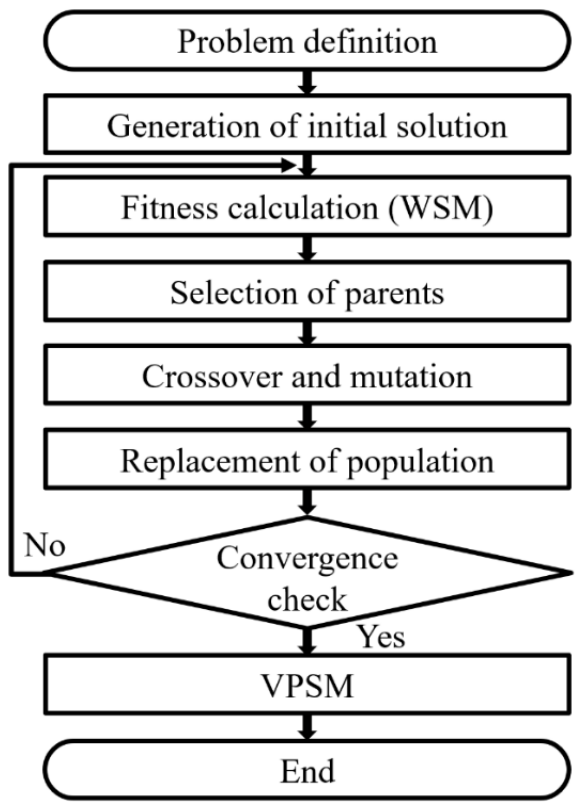
Figure 3. Flow chart of the IDP-GA.